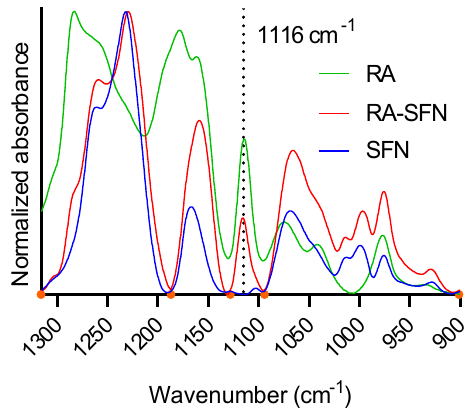
Figure 3. Baseline corrected and normalized infrared absorption spectra of SFNs, RA and RA-SFNs. Spectra are normalized to an absorbance of 1 at the maximum of the amide III band at 1229 cm − 1 . The RA spectrum is normalized to an absorbance of 1 at 1281 cm − 1 . All samples were measured as a dry film obtained from a 30% ethanol dispersion. Orange dots indicate the baseline points.